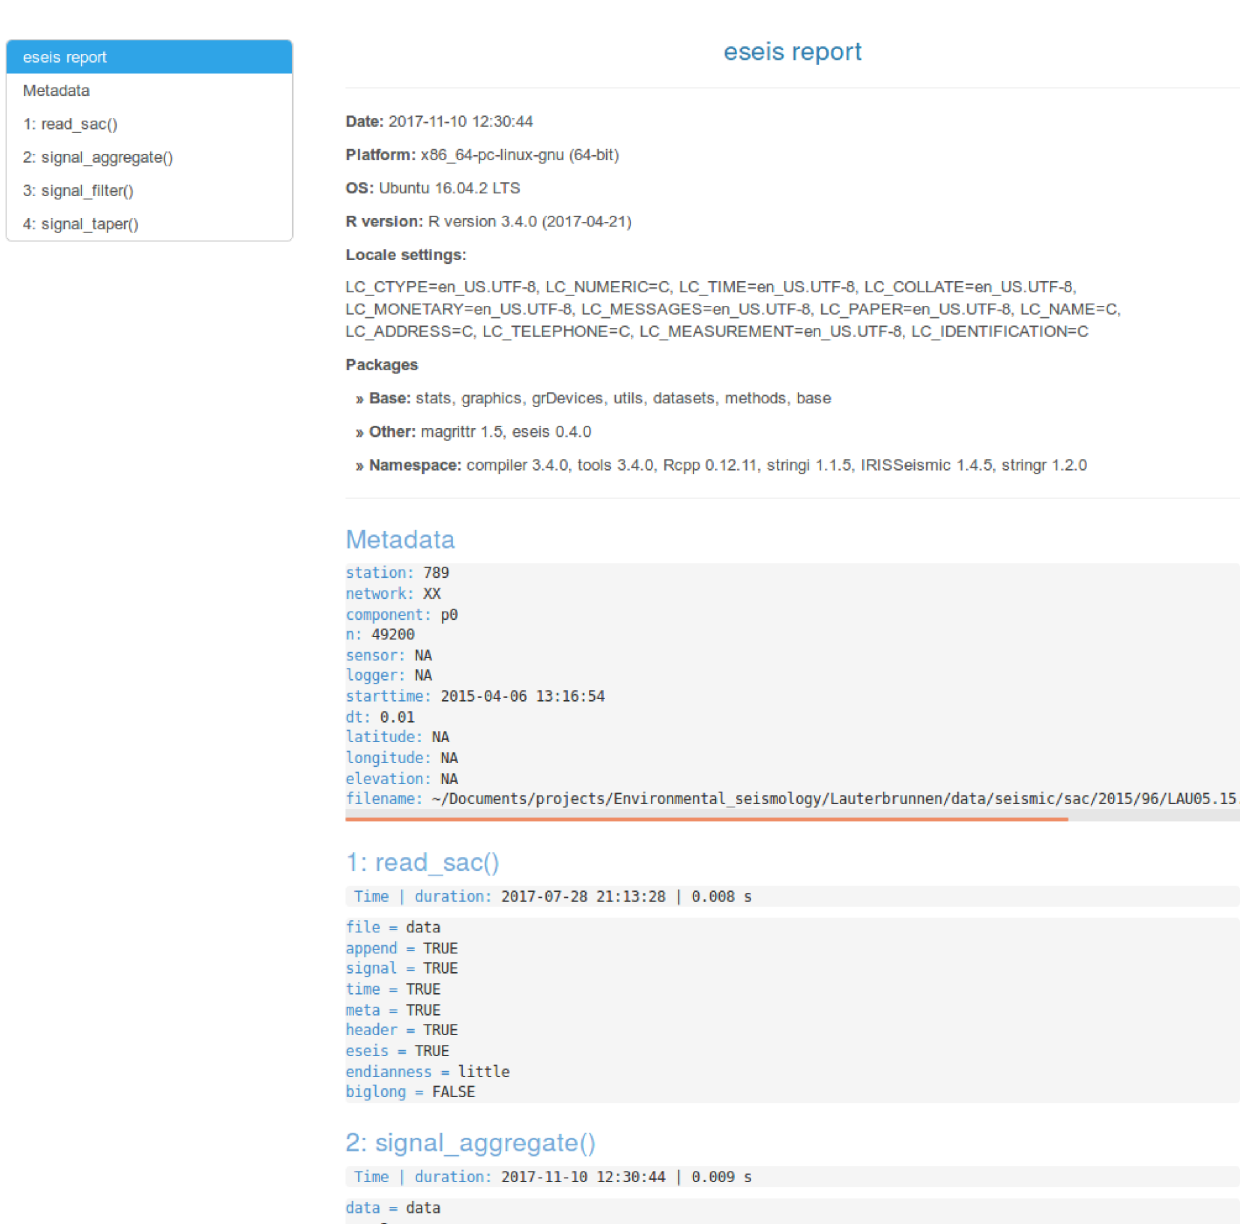
Figure 4. Section of the html-based report output. The interactive document lists the computer and software environment under which the processing took place, as well as all manipulation steps the data set was subjected to, including function calls and argument